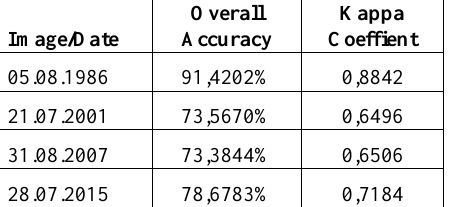
Figure 6: Landsat 7 TM (21/07/2001) a) minimum